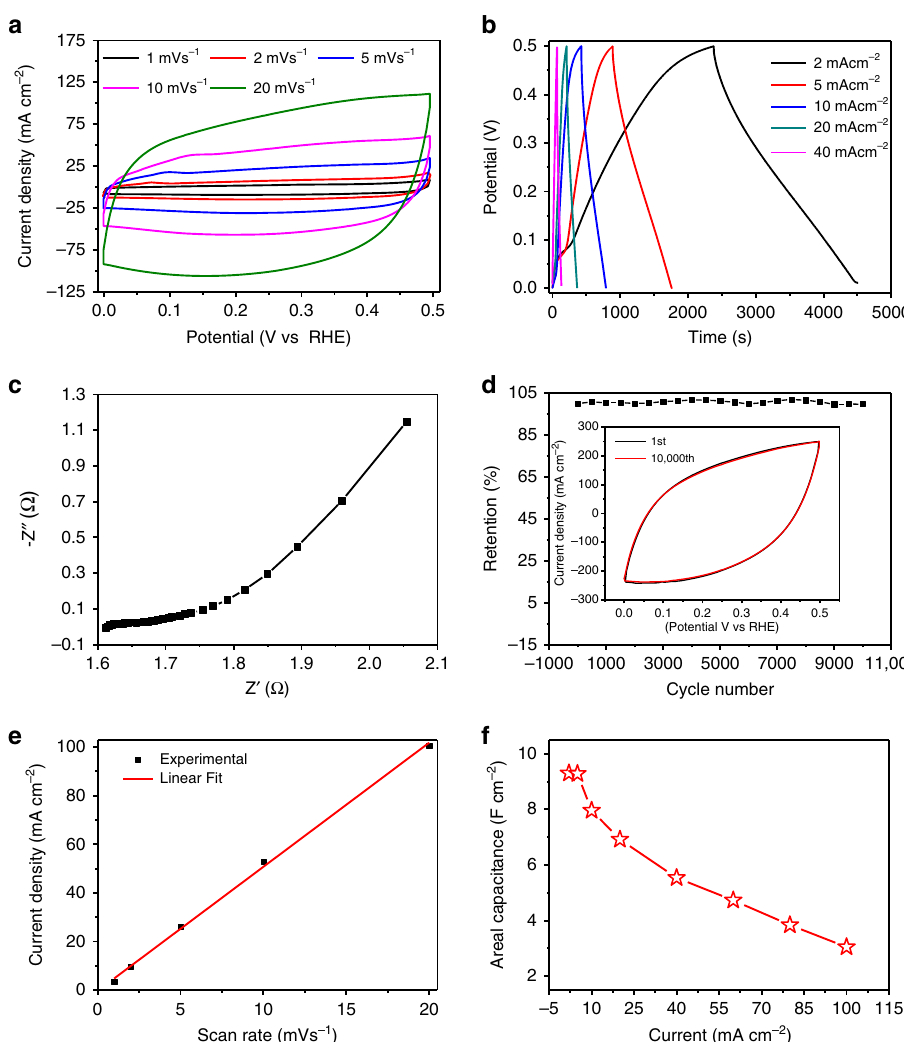
Fig. 5 Electrochemical performance of MoN single crystal in 1 M KOH electrolyte. a CV curves at different scan rate of porous MoN single crystal. b GCD curves at different current densities of the MoN crystal. c Nyquist plots of MoN crystal electrode before cycling. d Cycling performance of MoN single crystal at a scan rate of 50 mV s − 1 , inset shows the CV curves of the 1st and 10,000th cycles. e Linear dependence of current density on scan rate of CVs at scan rates from 1 to 20 mV s − 1 . f Areal capacitance as a function of current densities of MoN single